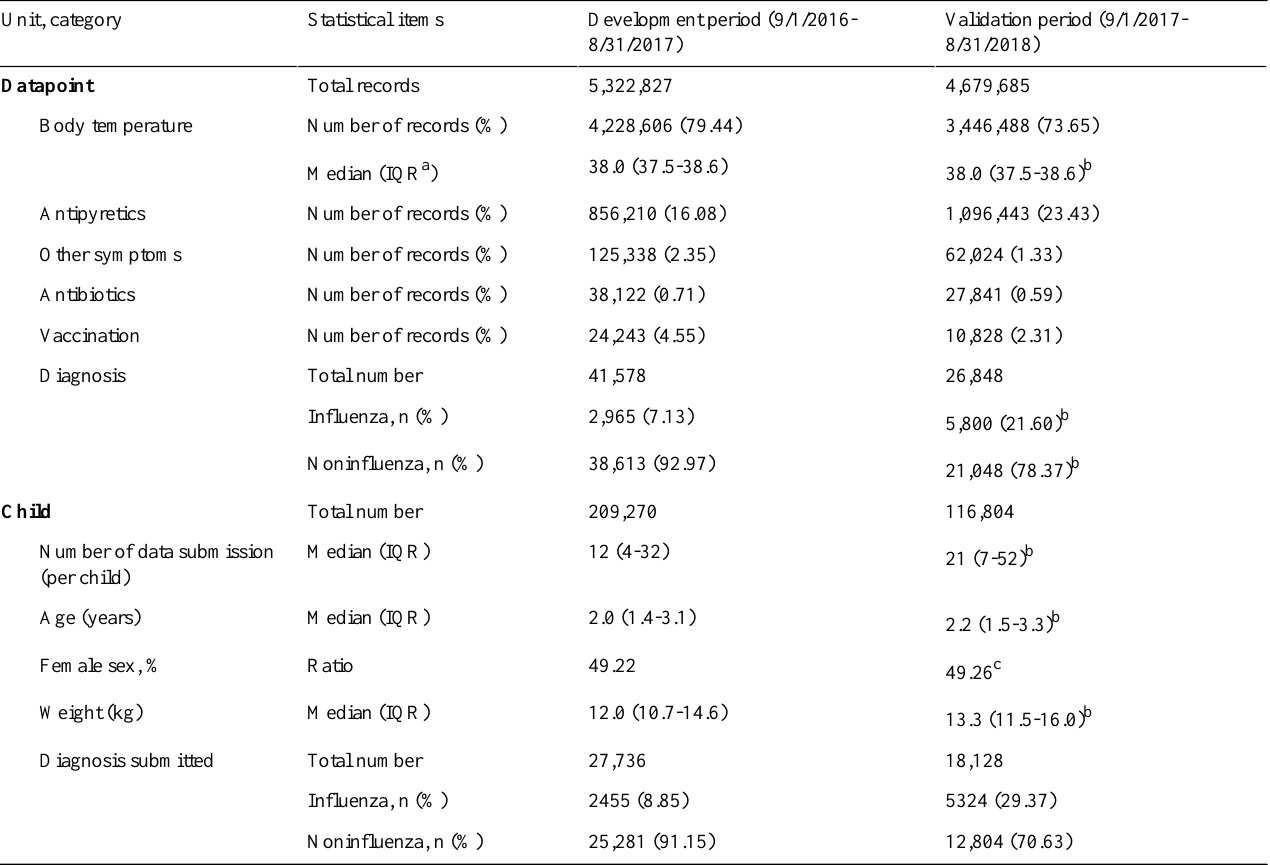
Table 1. User characteristics and number of datapoints submitted during the development and validation